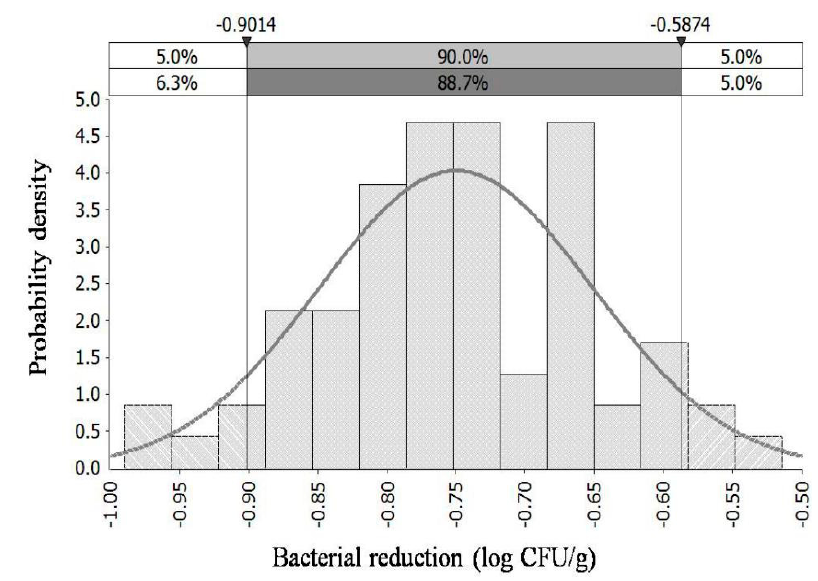
Figure 2. Probability distribution of Salmonella reduction on chicken breasts in chilling water with 20–100 mg/L of chlorine.